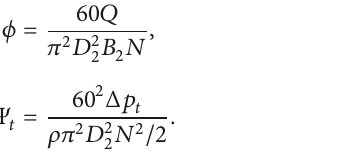
Figure 4: Compressor